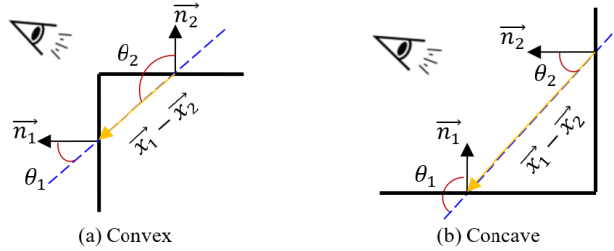
Figure 3. Illustration of the convexity/concave criterion.